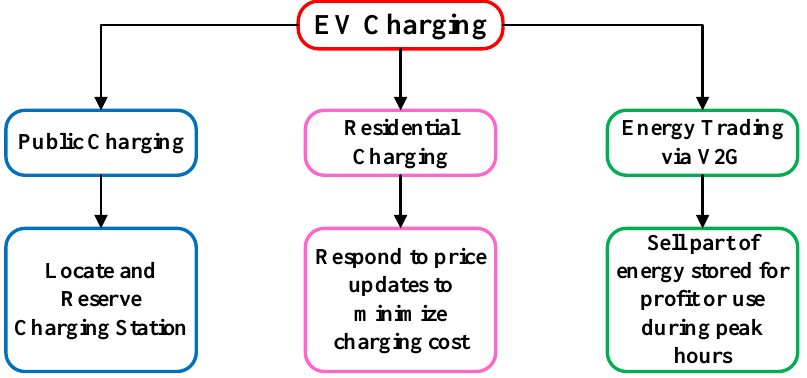
Figure 2. Electric Vehicle Charging Requirements.